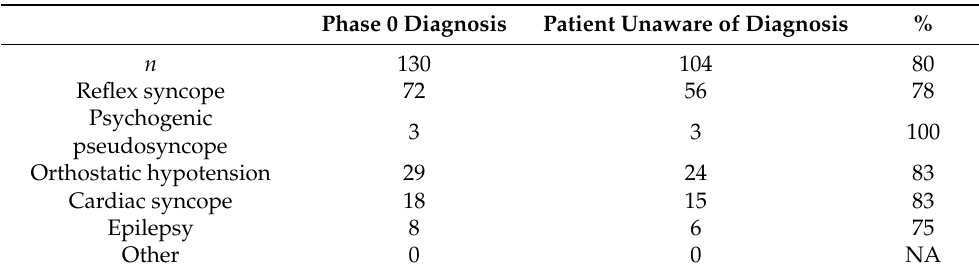
Table 3. Patients unaware of diagnosis of referring physician upon the consultation in the syn- cope